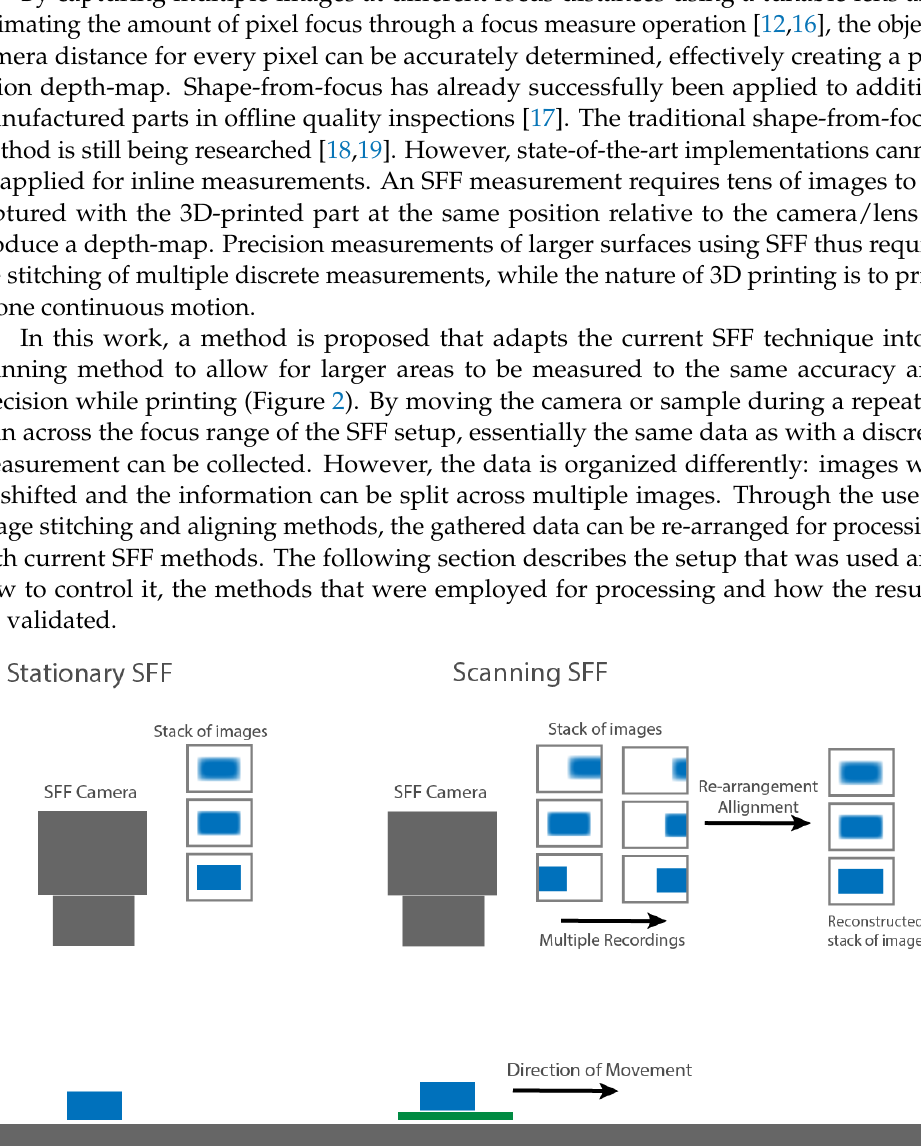
Figure 2. The concept of scanning SFF compared to stationary